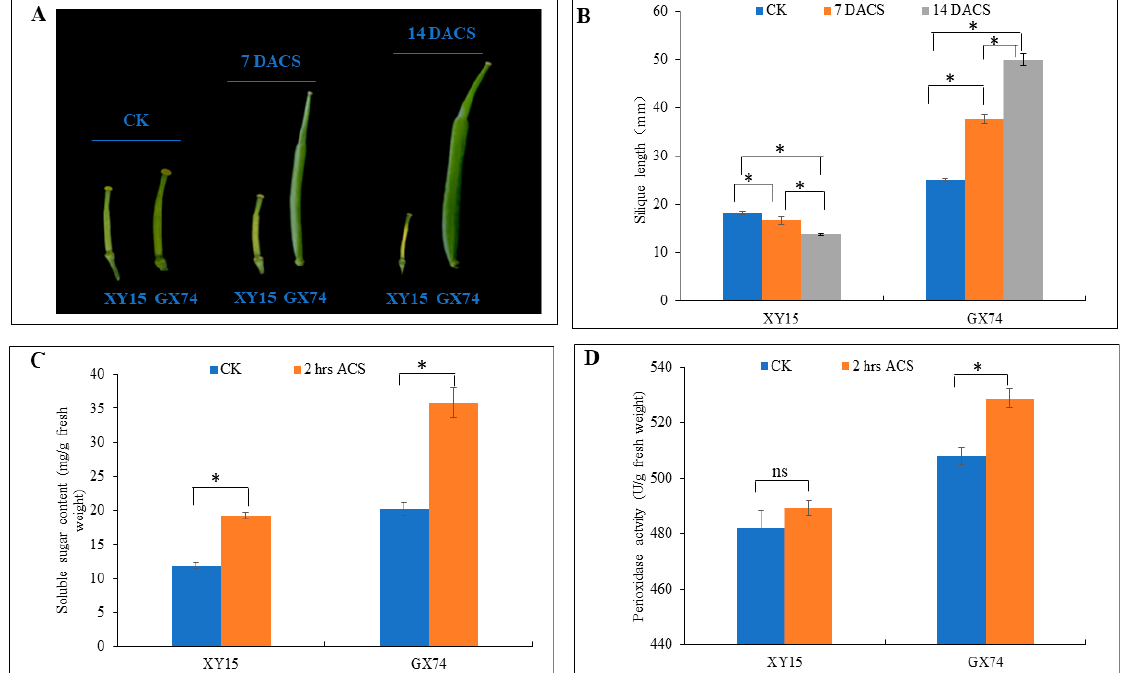
Figure 1. Physiological performance of XY15 (cold-sensitive) and GX74 (cold-tolerant) rapeseed genotypes. ( A ) Silique before cold stress (CK), and 7 and 14 days after cold stress (DACS), respectively. ( B ) silique length. ( C ) Soluble sugar content. ( D ) Peroxidase activity between CK and 2 h after cold stress (ACS). Error bars represent standard error of means. Bars with * indicate significant differences (by two-tailed t -test at p ≤ 0.05), while ns indicates no significant difference between the sampling periods.